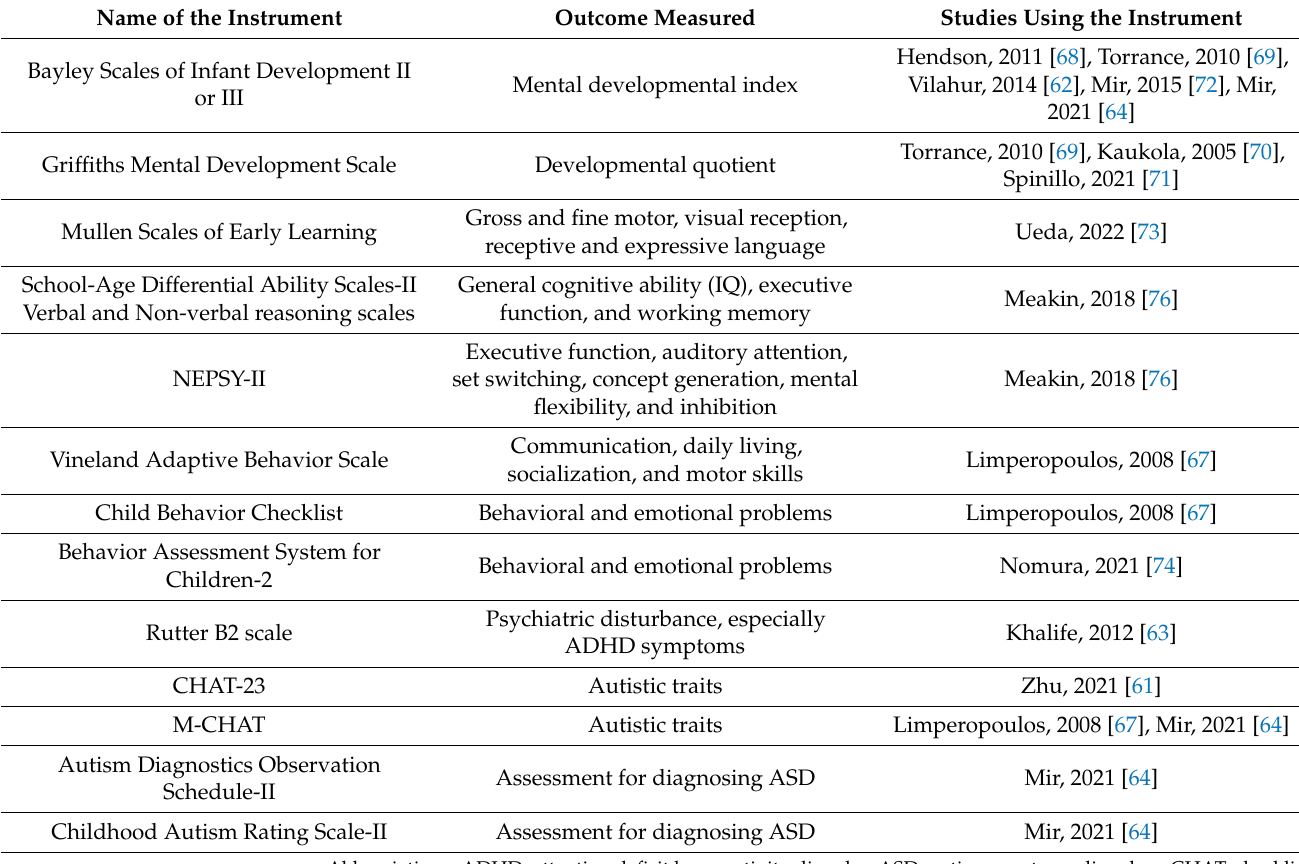
Table 4. Instruments used in the included studies for the assessment of psychological outcomes in